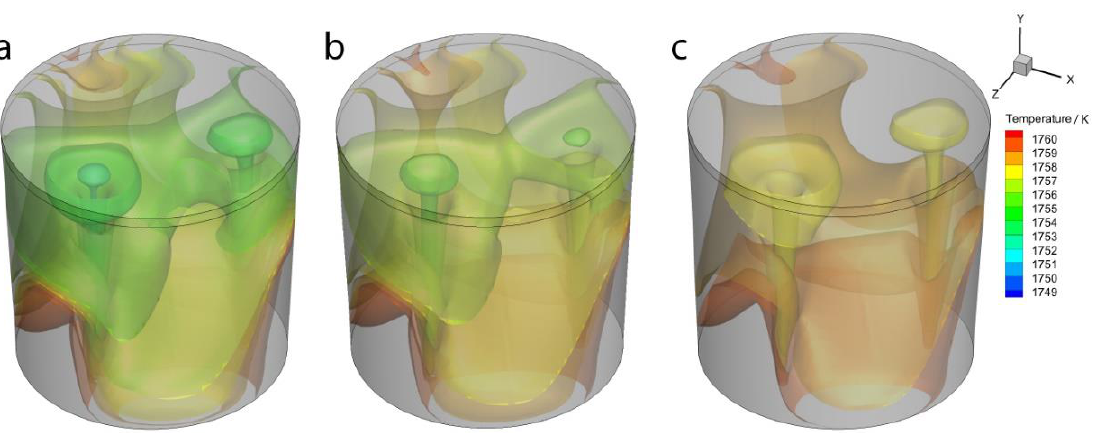
Figure 10. The temperature iso-surface under different initial bubble temperatures: ( a ) 25 °C, ( b ) 400 °C, and ( c ) 800 °C.